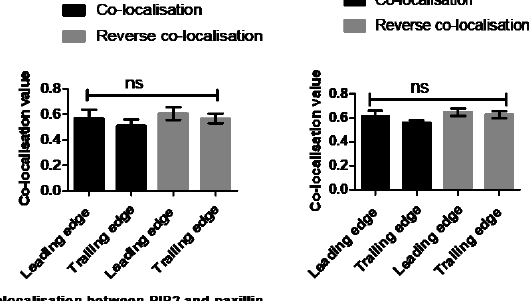
Figure 2 : Quantification of spatial co-localisation between PtdIns(4,5)P2and paxillin at the leading and trailing edges. Spearman’s (rho) correlation coefficient analysis was used to measure a co-localisation value between PtdIns(4,5)P2and paxillin at the leading and trailing edges. A) On fibronectin: Co-localisation and reverse co-localisation values between PtdIns(4,5)P2 and paxillin were moderate co-localisation. A) On collagen:Co-localisation and reverse co-localisation values between PtdIns(4,5)P2and paxillin were moderate co- localisation. Statistical analysis was performed by One-way ANOVA with Tukey's Multiple Comparison Test, non- significant differences between co-localisation values at P≤0.05. Data are a representative of the means±SD of three independent experiments in which n=10 cells were measured, and number of a single FA=10 for each cell.